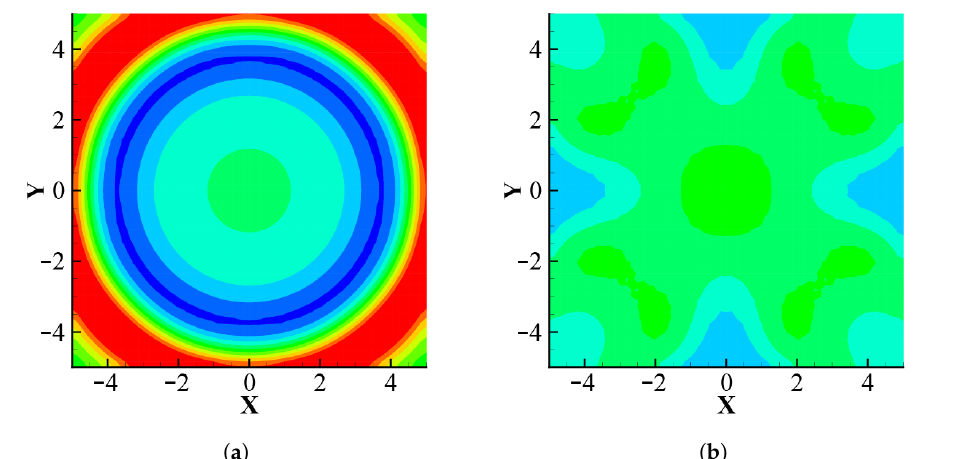
Figure 5. Two-dimensional acoustic pulse ( a ) at t = 5/ c ∞ for − 0.004 ≤ p (cid:48) / p ∞ ≤ 0.004 and ( b ) at t = 10/ c ∞ for − 0.001 ≤ p (cid:48) / p ∞ ≤ 0.001. 10 contour levels are shown.